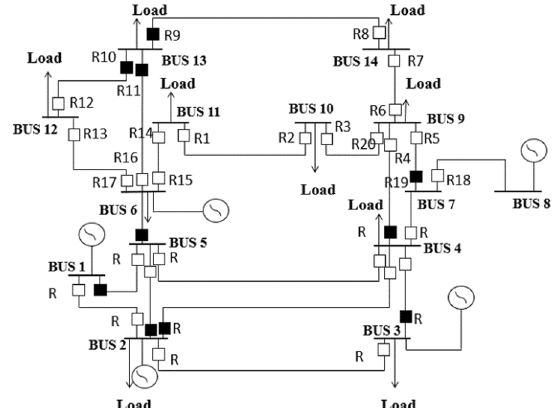
Fig. 1 MBPS of IEEE 14-bus system